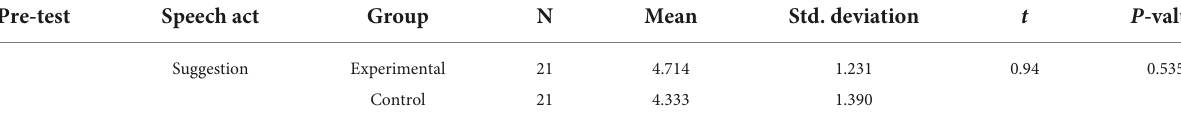
TABLE 5 Independent sample t -test between experimental and control groups for pre-test (Suggestion).